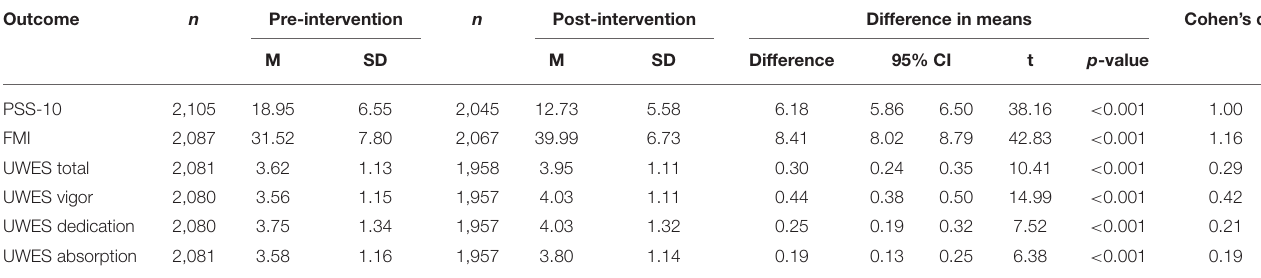
TABLE 2 | Future Learn MOOC–results for stress, mindfulness, and work engagement following participation in mindfulness training. Outcome n Pre-intervention n Post-intervention